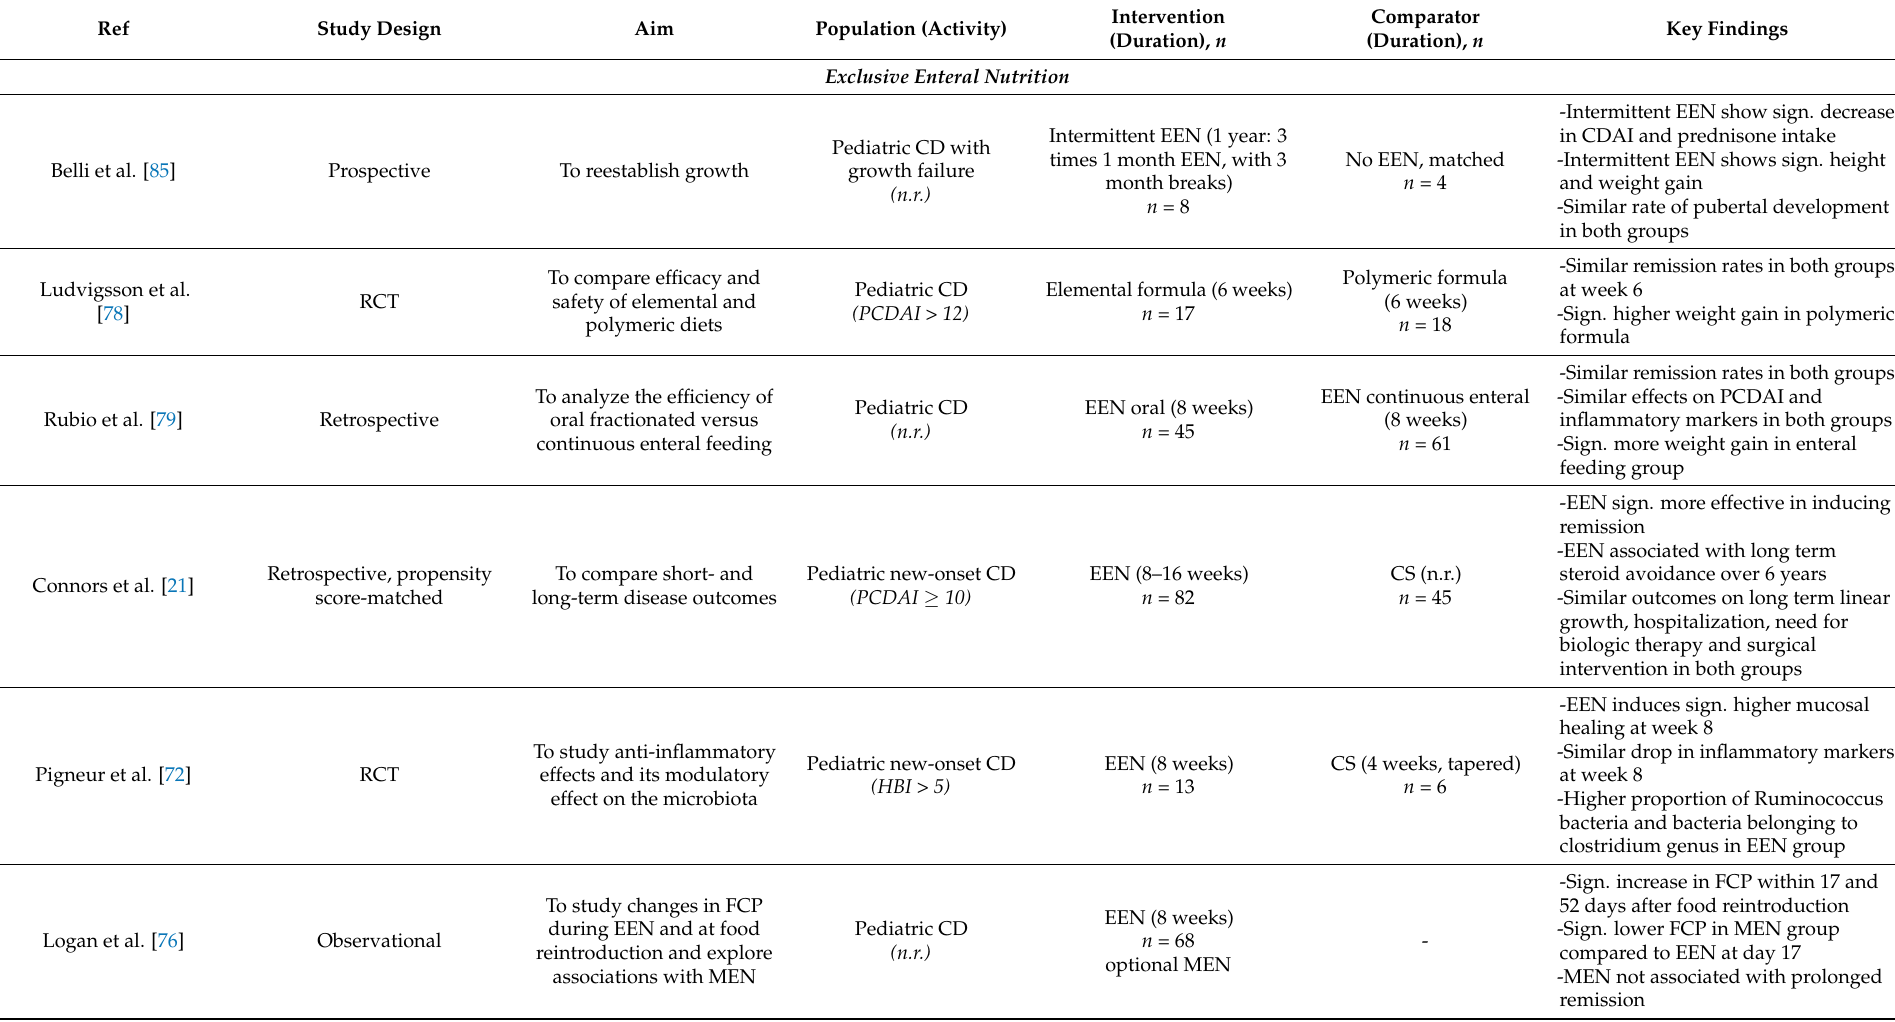
Table 1. Summary of the nutritional therapy intervention studies in children with Crohn’s disease, as described in Section